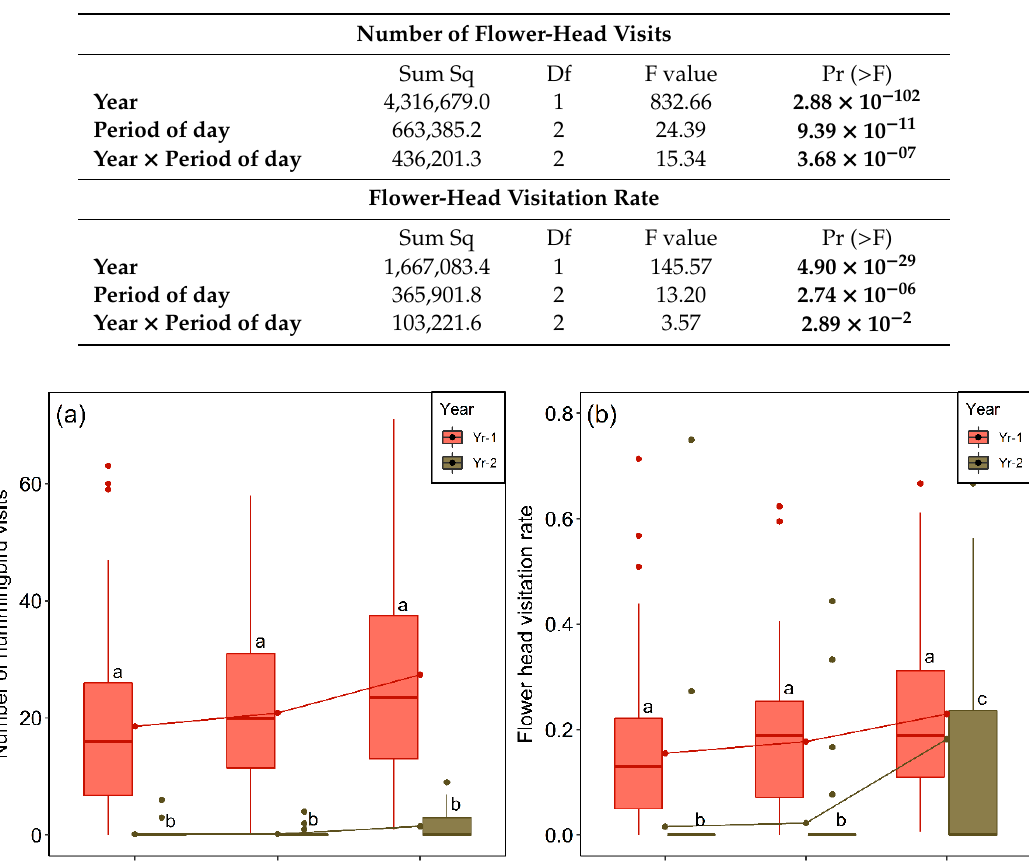
Table 2. Results of the nonparametric factorial analysis (Aligned rank transformed) for the number of visits to M. subulata flower-heads and flower-head visitation rates considering the last two years of the Chilean mega drought. Significant e ff ects are shown in bold.